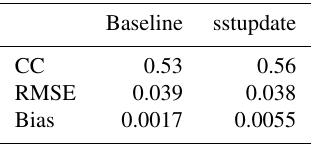
Table 3. Metrics including the correlation coefficient (CC), root mean square error (RMSE), and bias for TI that are computed based on total (sub-grid and resolved) TI simulated by baseline and sstup- date